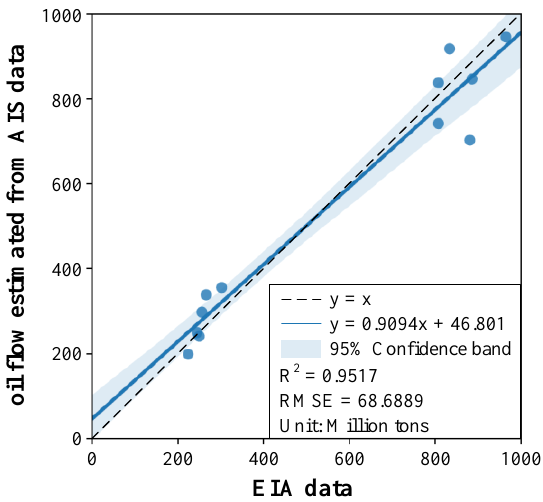
Figure 7. A scatter plot and linear fitting of the estimated oil flow and the EIA data.